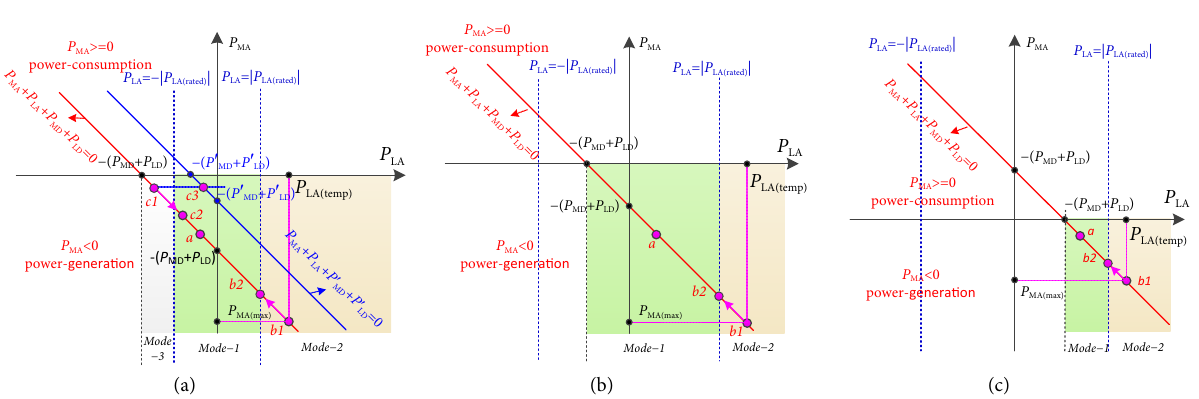
Fig. 2 LVRT mode classification of the PET under different power configurations in the power-generation state of the MVac port. (a) Case 1 , | P LA(rated) | < P MD + ⩾ P LD . (b) Case 2 , | P LA(rated) | P MD + P LD > 0. (c) Case 3 , | P LA(rated) | > − P MD − P LD